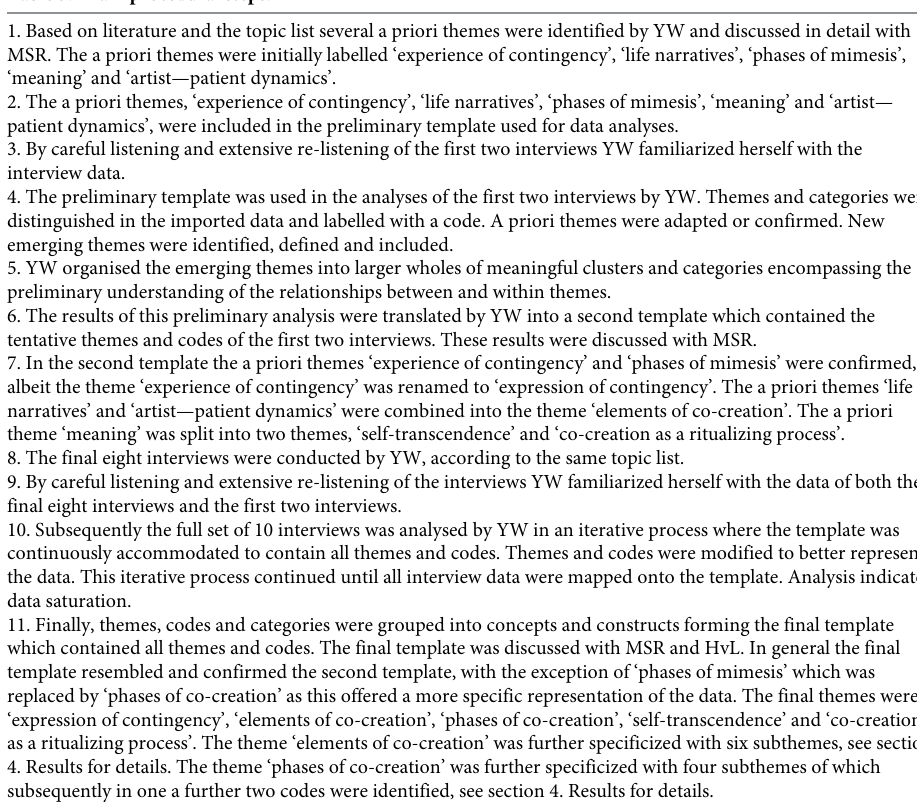
Table 3. Main procedural